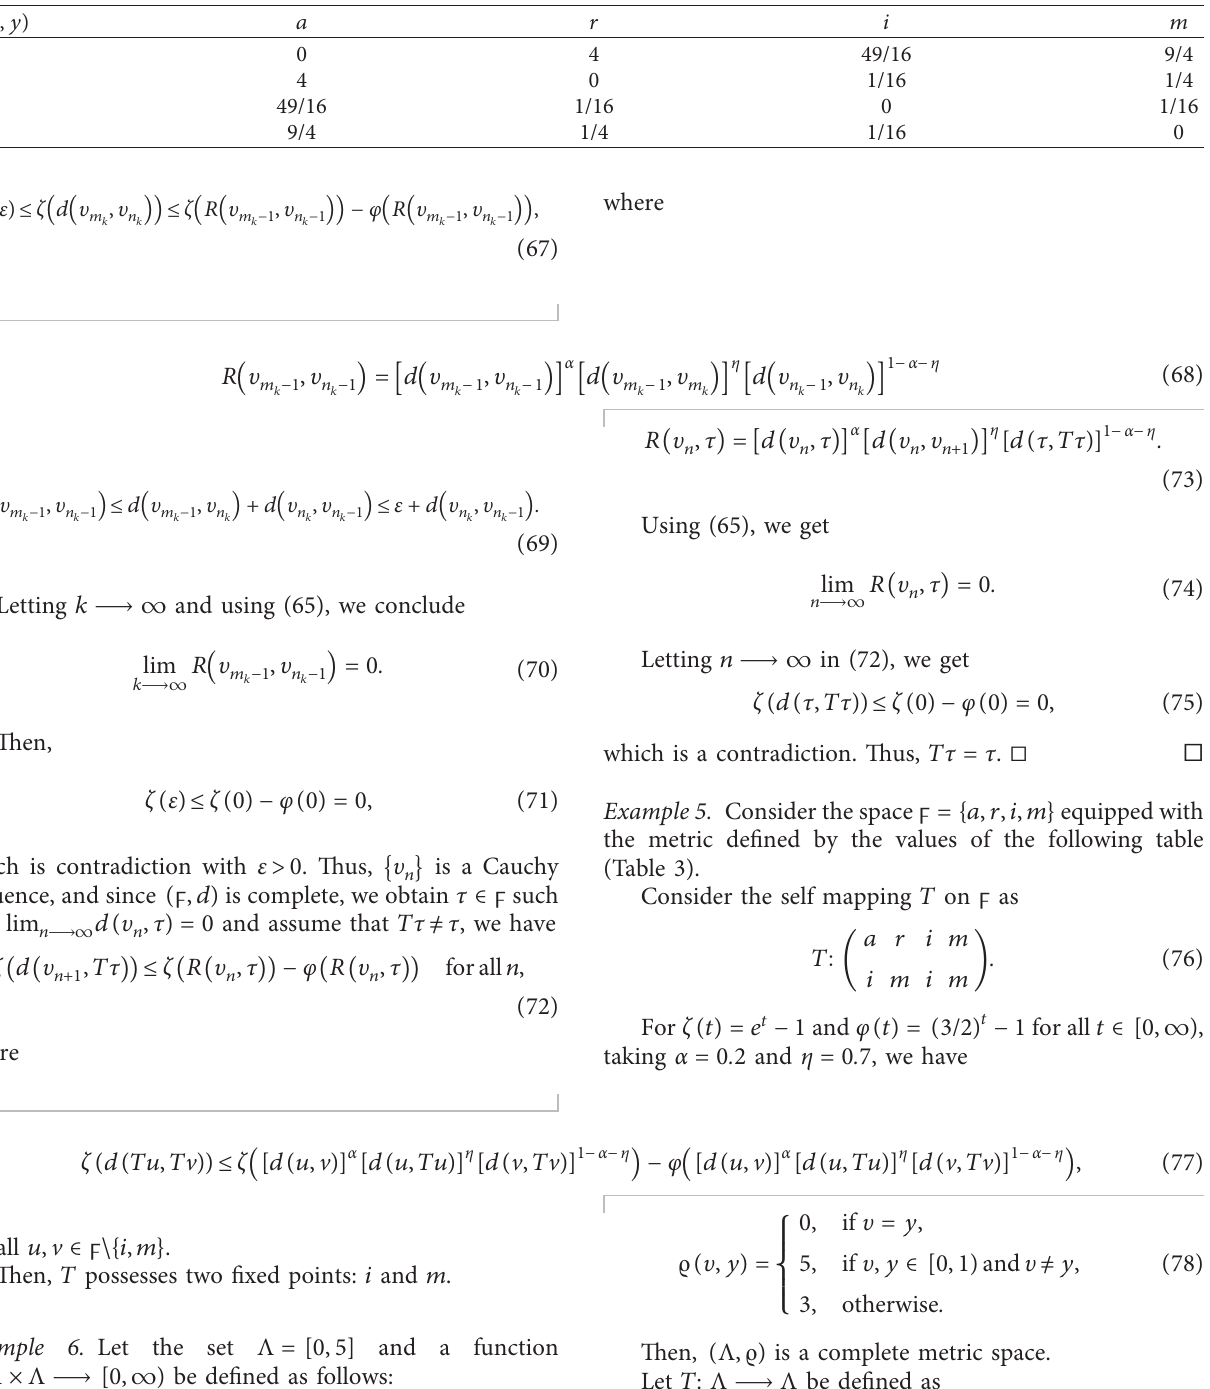
Table 2: Table of metric d for Example